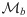
Global RoCoF disturbance magnitude Mb vs. artifically modified total system inertia.Along paths (1) and (3), inertia is added according to procedure (11), i.e. mostly on the non-Fiedler area. Path (2) follows procedure (10) by adding inertia almost exclusively on the Fiedler area. Path (4) follows a selected procedure where inertia is removed from the Fiedler area and added on the non-Fiedler area. The top left data point corresponds to the data point indicated by an arrow in Fig 10.